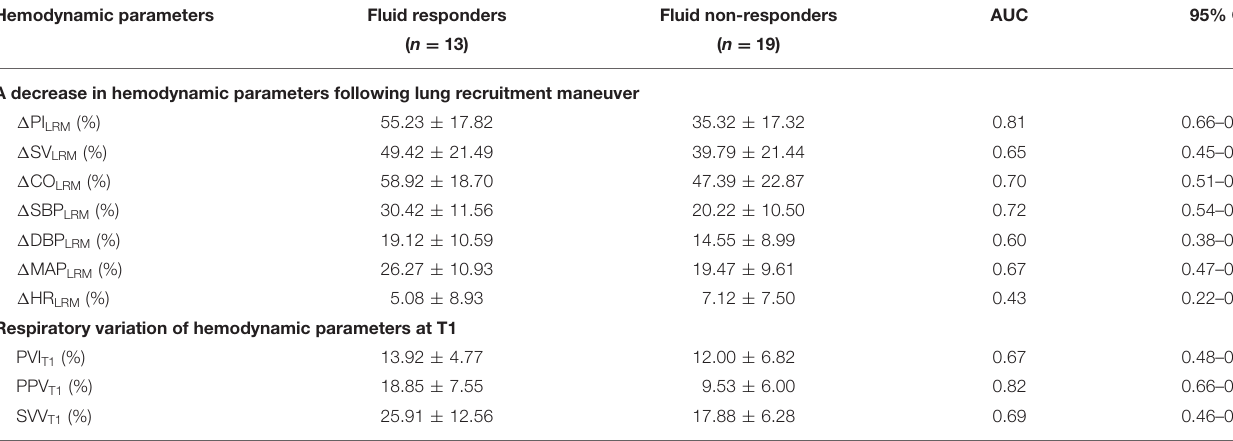
TABLE 3 | The changes in hemodynamic parameters and their AUCs in predicting fluid responsiveness. Hemodynamic parameters Fluid responders